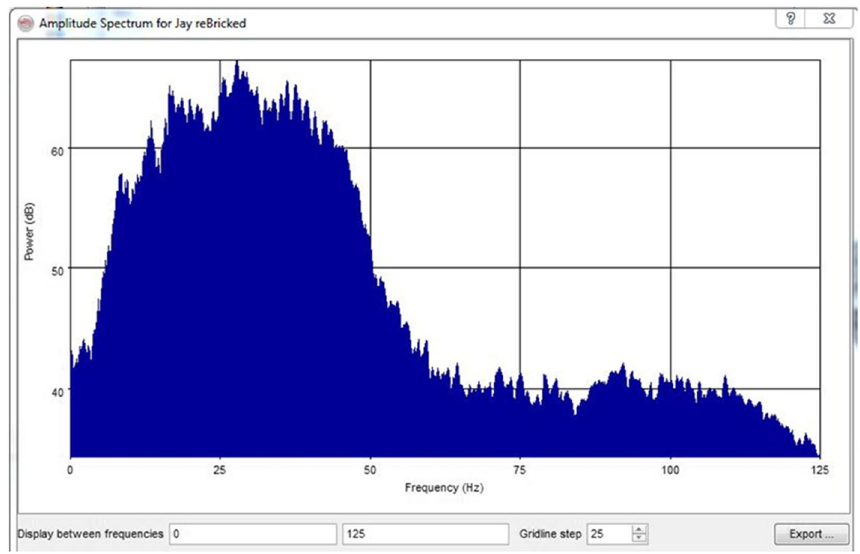
Fig. 8 Spectral decomposition attribute frequency spectrum of Jay